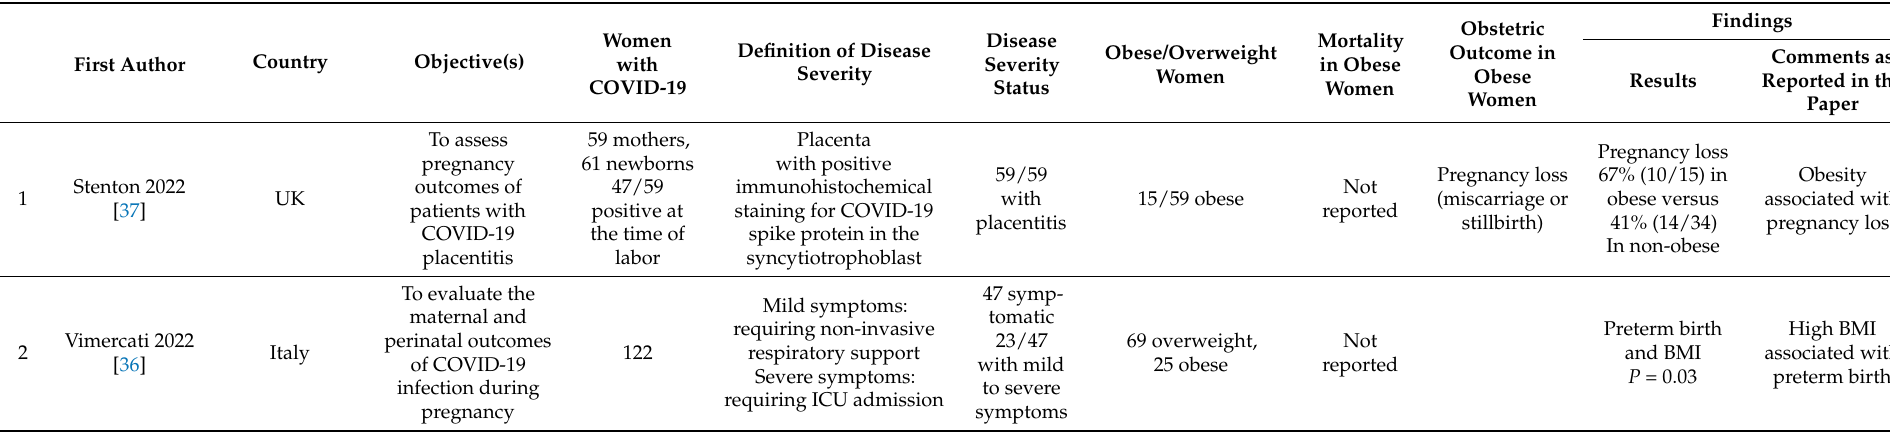
Table 4. Association of overweight/obesity with pregnancy outcomes in Covid-19 patients.